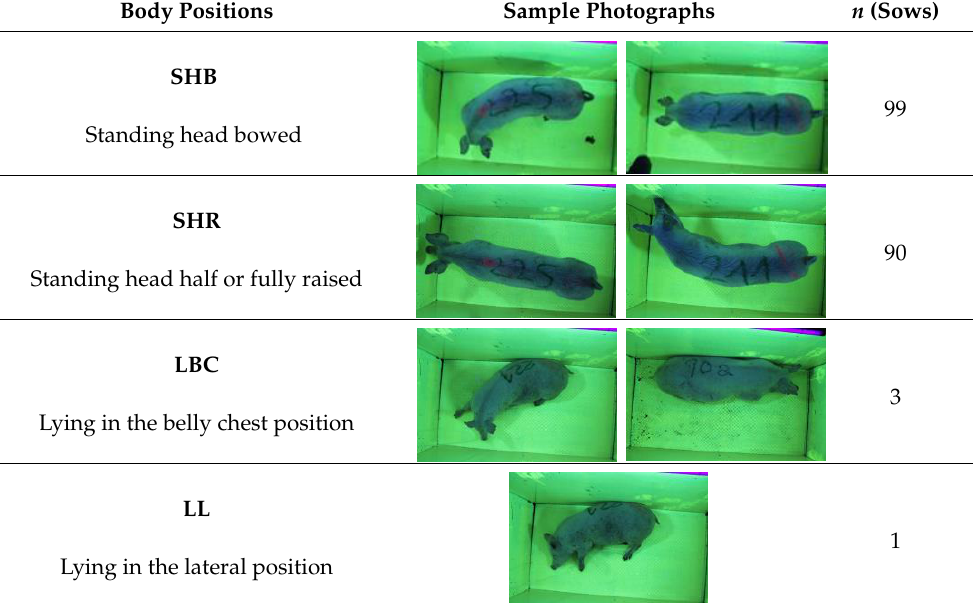
Table 2. Different body positions and the number of sows in each body position. Body Positions